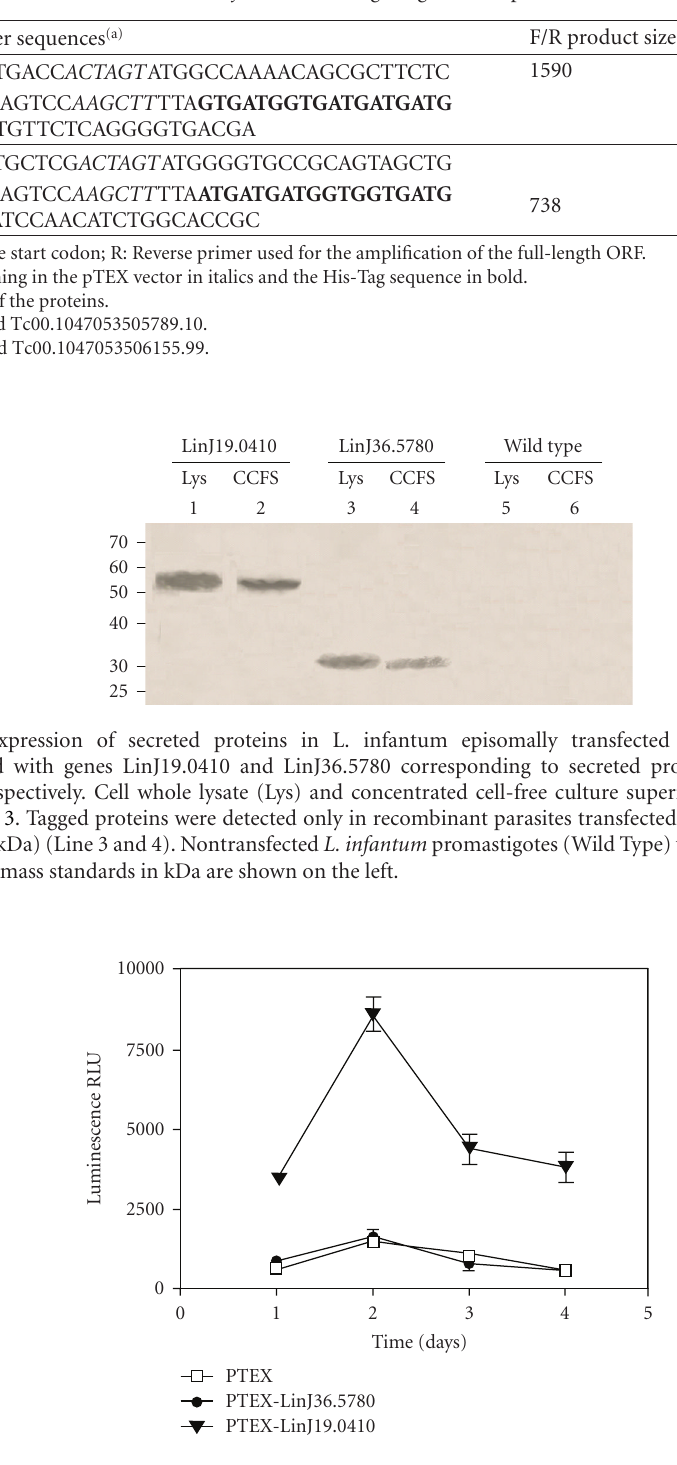
Figure 5: Bioluminescence activity of intracellular Leishmania expressing episomal luciferase from infected macrophages in vitro. Recombinant L . infantum promastigotes overexpressing the secreted proteins pTEX-LinJ19.0410 ( (cid:2) ) or pTEX-LinJ36.5780 ( • ) were cotransfected with the pSP-Y α HYGRO α LUC carrying the firefly-luciferase gene. Survival of luciferase-expressing parasites was monitored in infected human monocyte cell line THP-1 di ff erentiated into macrophages as indicated in the Methods section. Promastigotes transfected with the pTEX vector alone and the pSP- α HYG α LUC ( (cid:3) ) were used as control for infection experiments. RLUs (Relative Luminescence Units) were measured at various time points post infection using the Steady Glo reagent. Results are expressed as the mean of three independent experiments, each carried out in